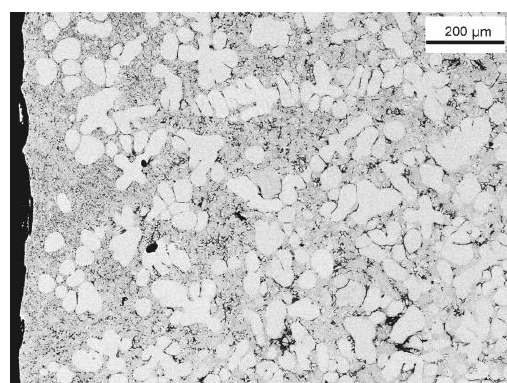
Figure 3. Distribution of Al-Si eutectic from the outer surface to the centre of the casting.